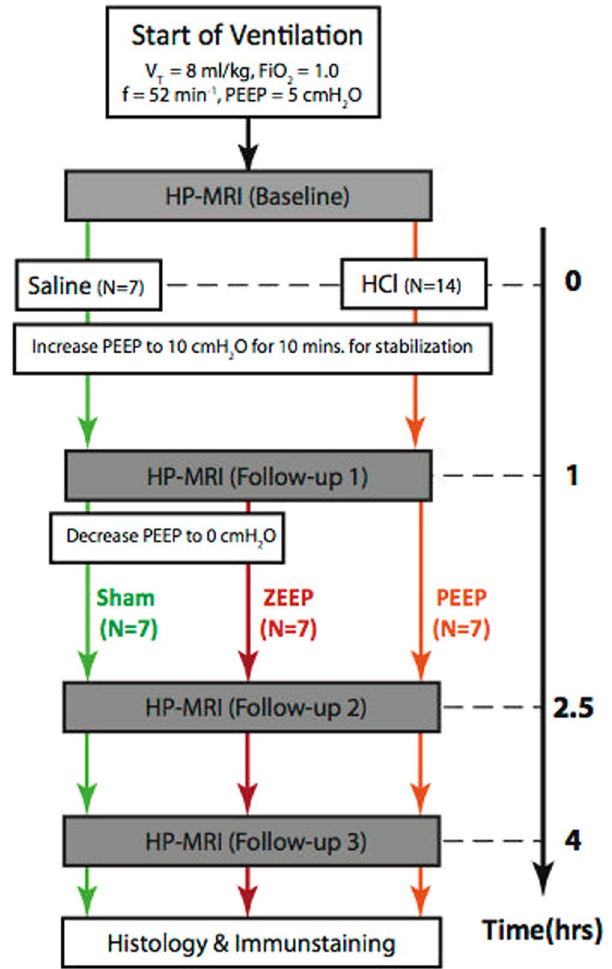
Figure 1. Summary of hyperpolarized carbon-13 imaging studies. A healthy baseline carbon-13 image was initially acquired. Rats received 0.5 ml/kg of either hydrochloric acid (N = 14) or saline (N = 7) 10 minutes after the baseline scan. Immediately after, positive-end expiratory pressure (PEEP) was increased to 10 cmH 2 O during a 10-minute stabilization period and was lowered back to 5 cmH 2 O. After 1 hour, the first follow-up carbon-13 image was acquired. PEEP was then lowered to 0 cmH2O in the rats receiving saline instillation (Sham group) and in seven injured rats (ZEEP group). Subsequent carbon-13 images were acquired 2.5 and 4 hours after acid/saline instillation. (Note that four animals from in the ZEEP group did not receive the third injection. Statistics are corrected for the unbalanced